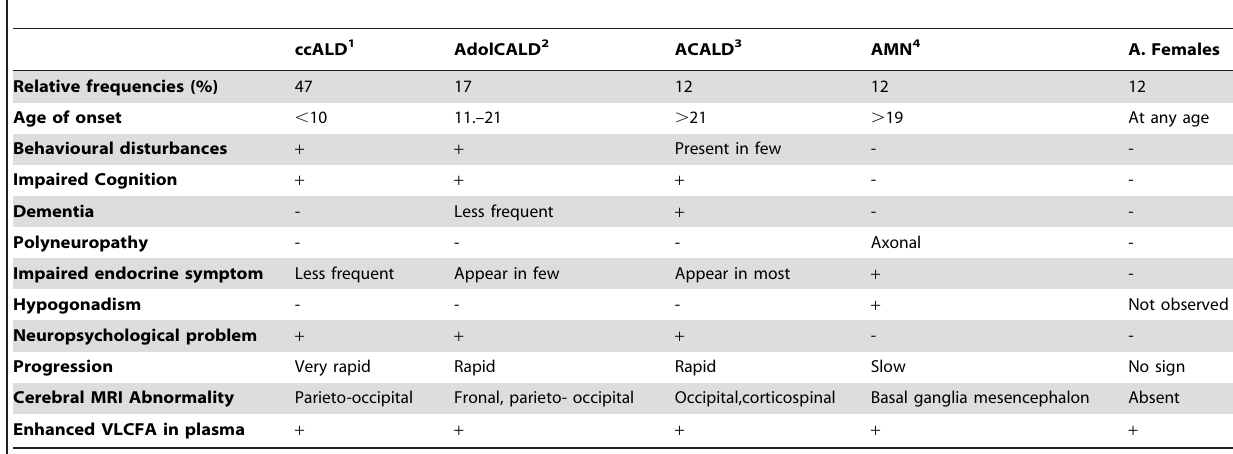
Table 2. Neurological, radiological, biochemical and other clinical examination within different phenotypes of